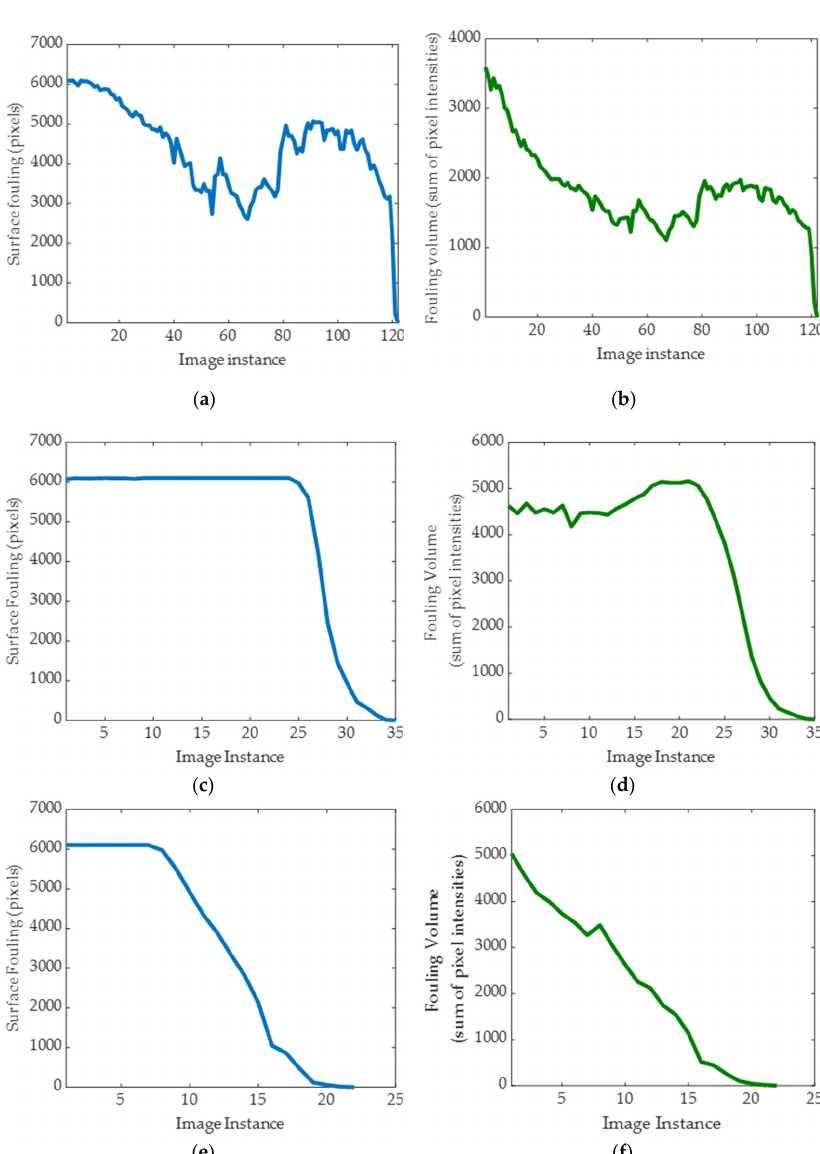
Figure 12. Surface fouling for gravy_cold_1 ( a ), fouling volume for gravy_cold_1 ( b ), surface